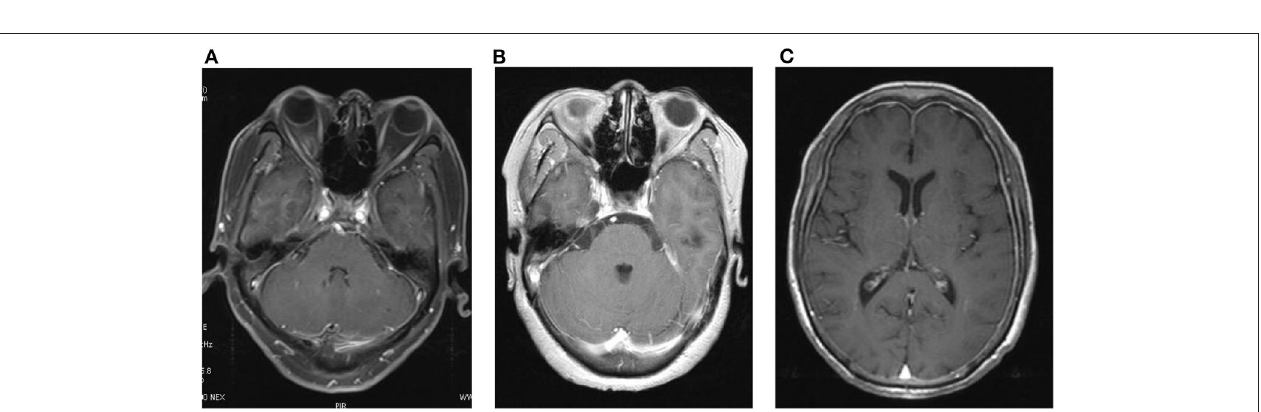
FIGURE 1 | Demographics for HP patients of different etiologies. (A) Proportion of HP patients according to different etiologies. (B) Number of patients according to genders. (C) Age of onset for patients of different etiologies.